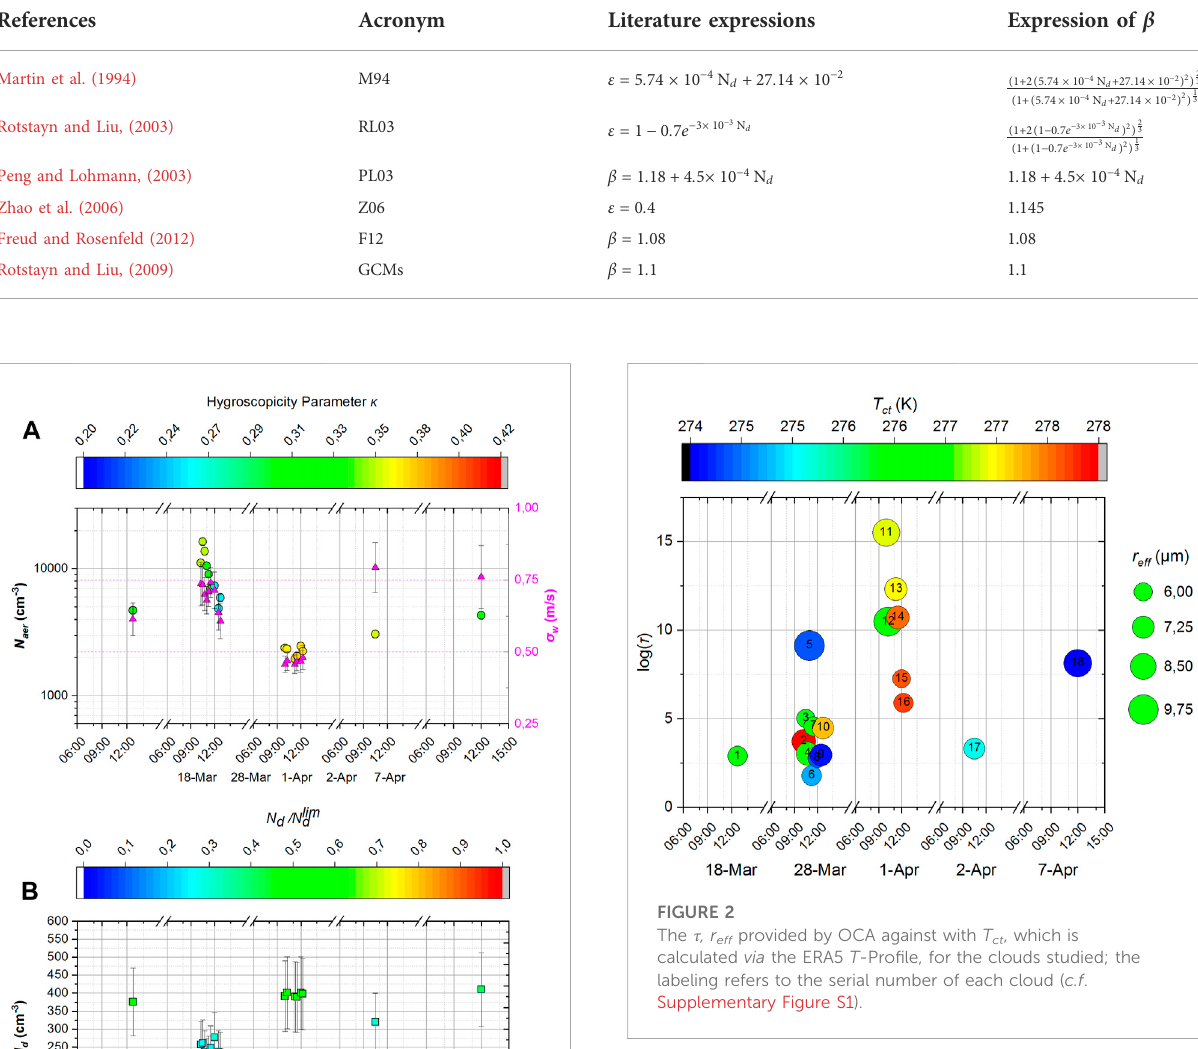
Moreover, the relevant uncertainty of the characteristic velocity w * can be estimated as δ w * (cid:2) 0 . 456 δσ w , where the error δσ w is estimated as the standard deviation of σ w in the fi tting process. Another important parameter to consider is the “ limiting droplet number ” , N d lim , at cloud top, which helps to estimate the degree to which clouds are susceptible to changes in aerosol content. N d lim is obtained from the relationship given by Georgakaki et al. (2021):